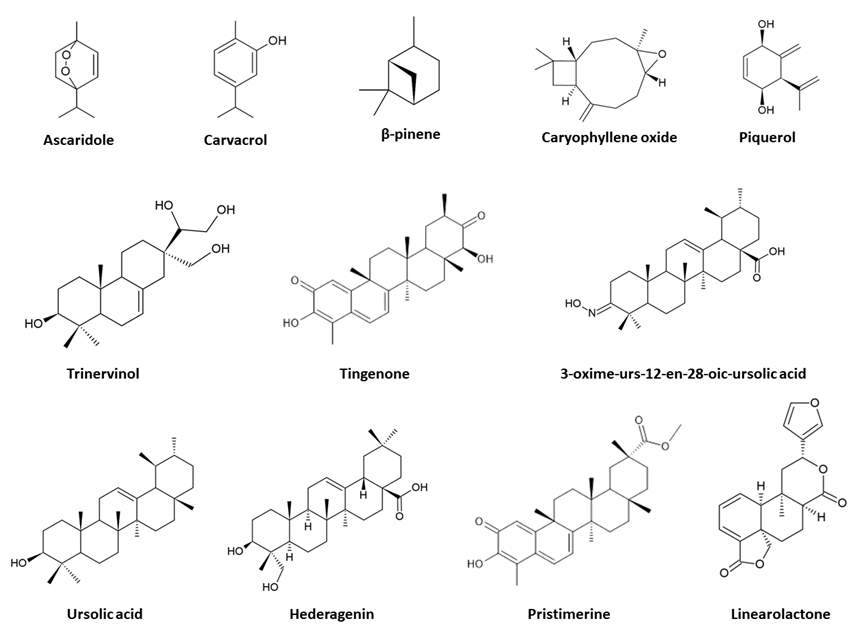
Figure 1. Chemical structures of some promising terpenes and essential oils components against amitochondriate protists.